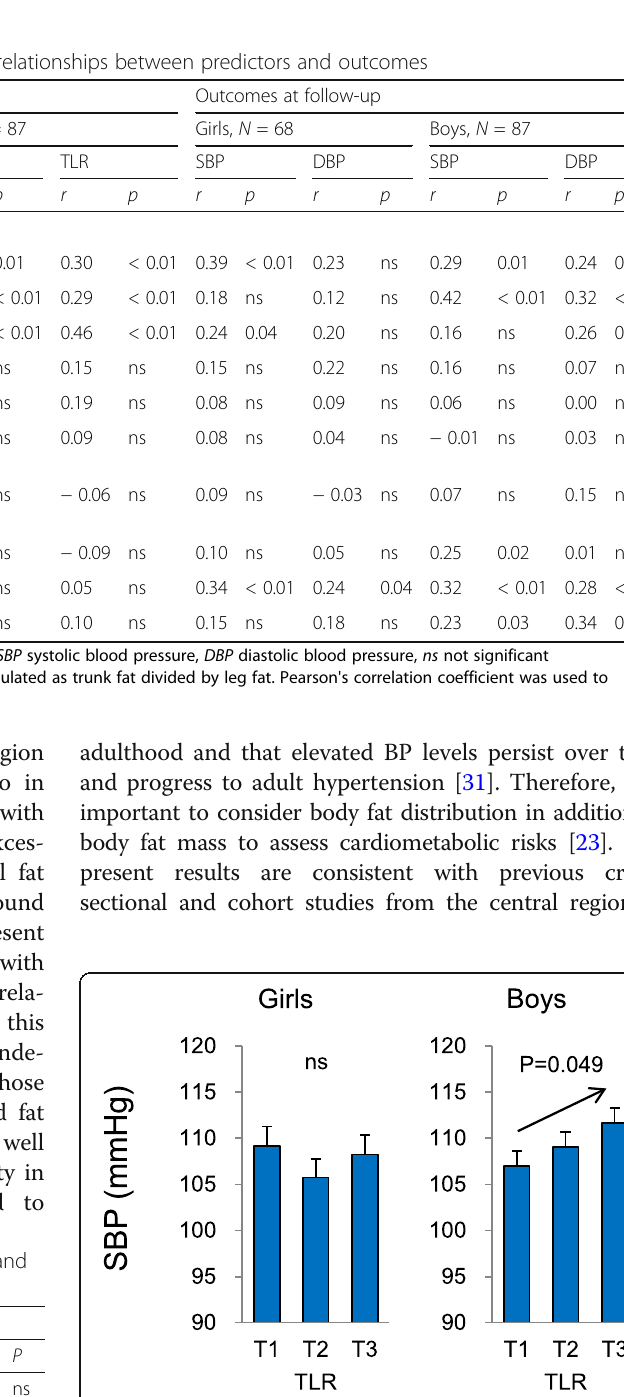
Potential confounding factors at baseline